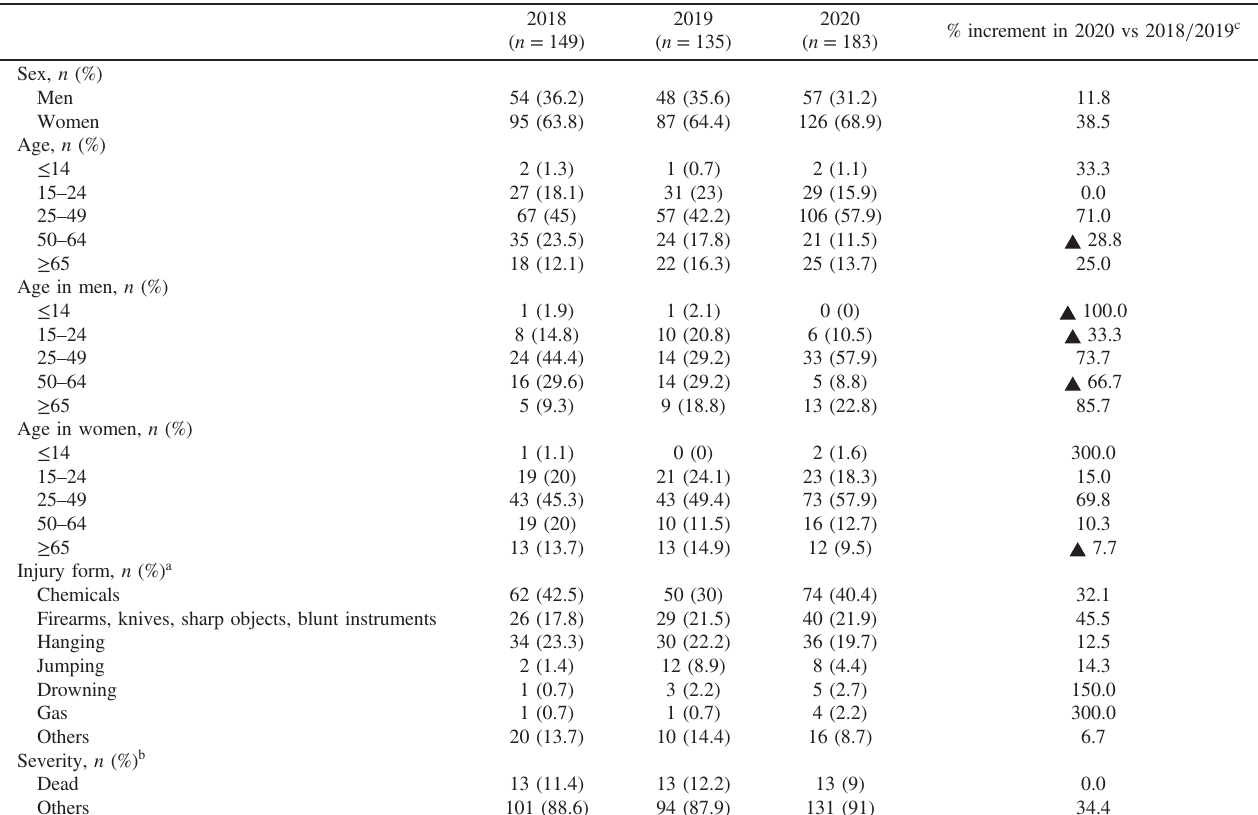
Table 2. Characteristics of subjects who attempted suicide obtained from information on emergency dispatches in Okayama City and